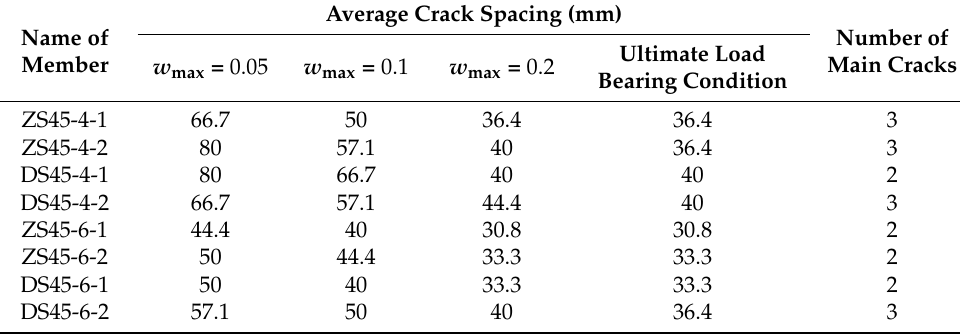
Figure 14. Load–maximum-crack-width curves. Table 6. Average crack spacing and number of main